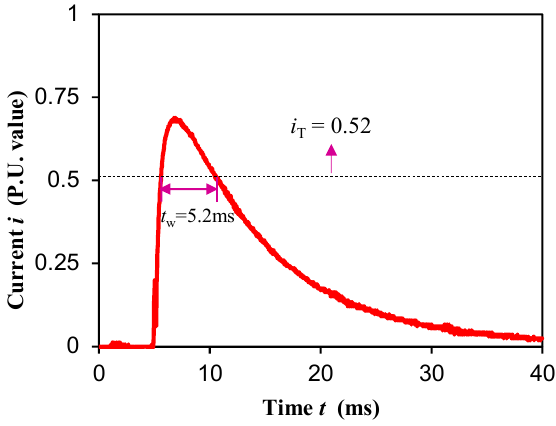
Figure 13. Discharge current curve of the low power supply which critically enables the switchover of the prototype.